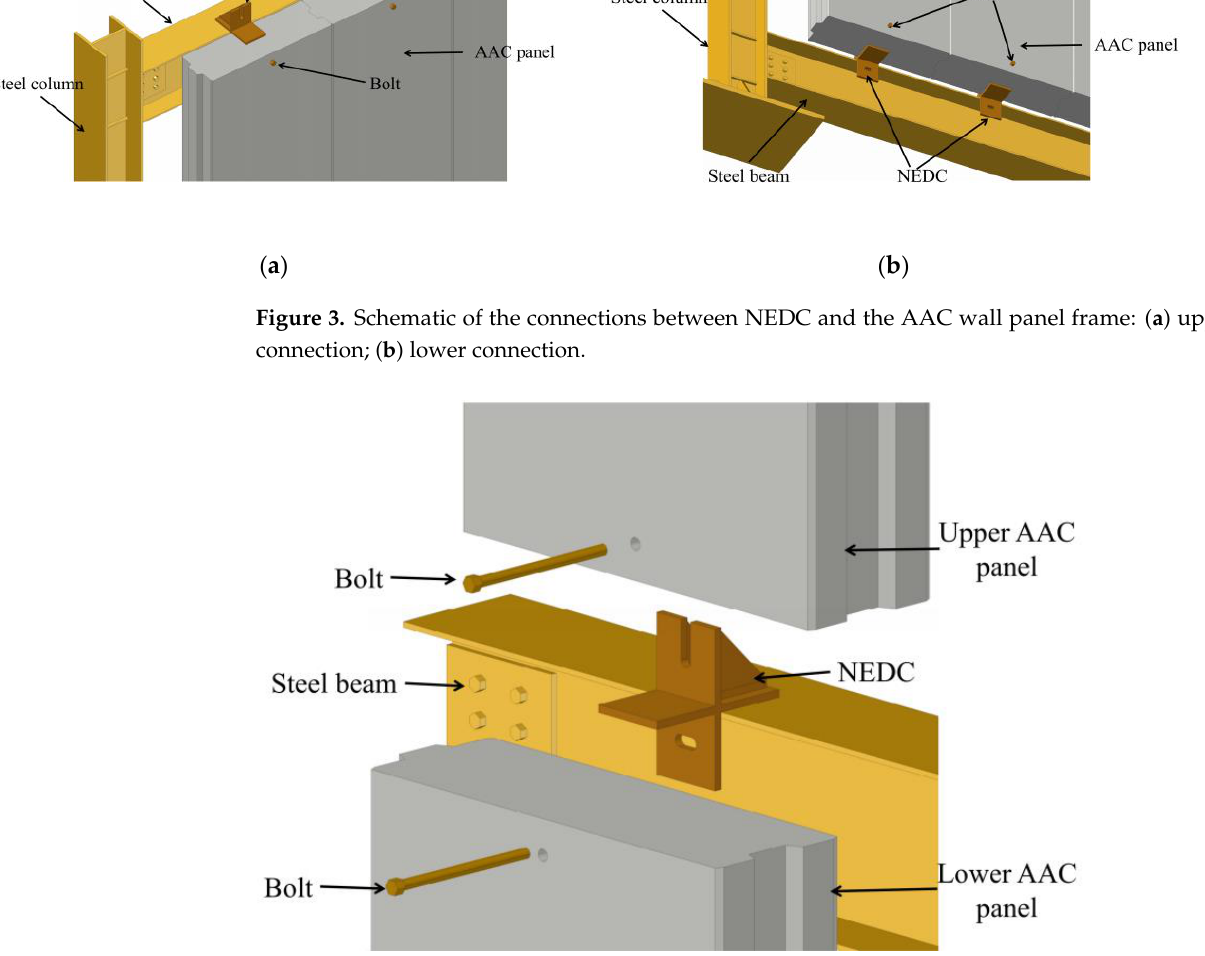
Figure 3. Schematic of the connections between NEDC and the AAC wall panel frame: ( a ) upper connection; ( b ) lower connection.